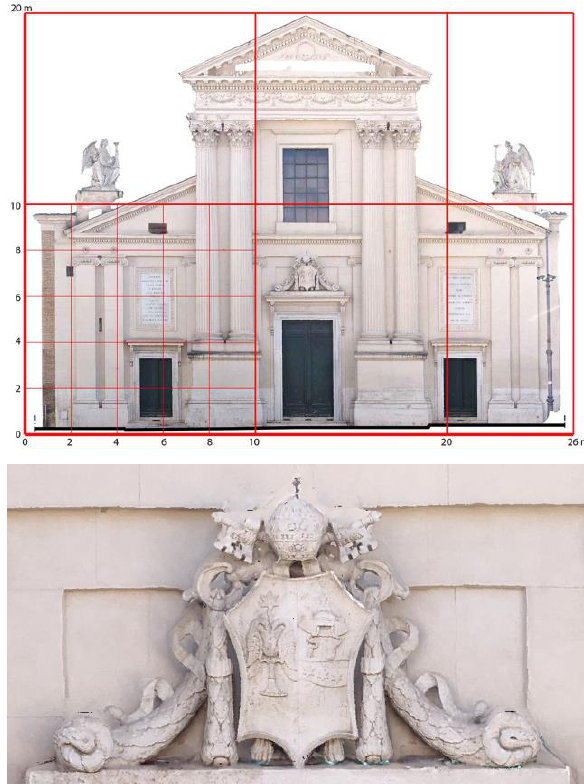
Figure 6. Final orthoimage of the whole façade with metric scale and sculptural detail above the main